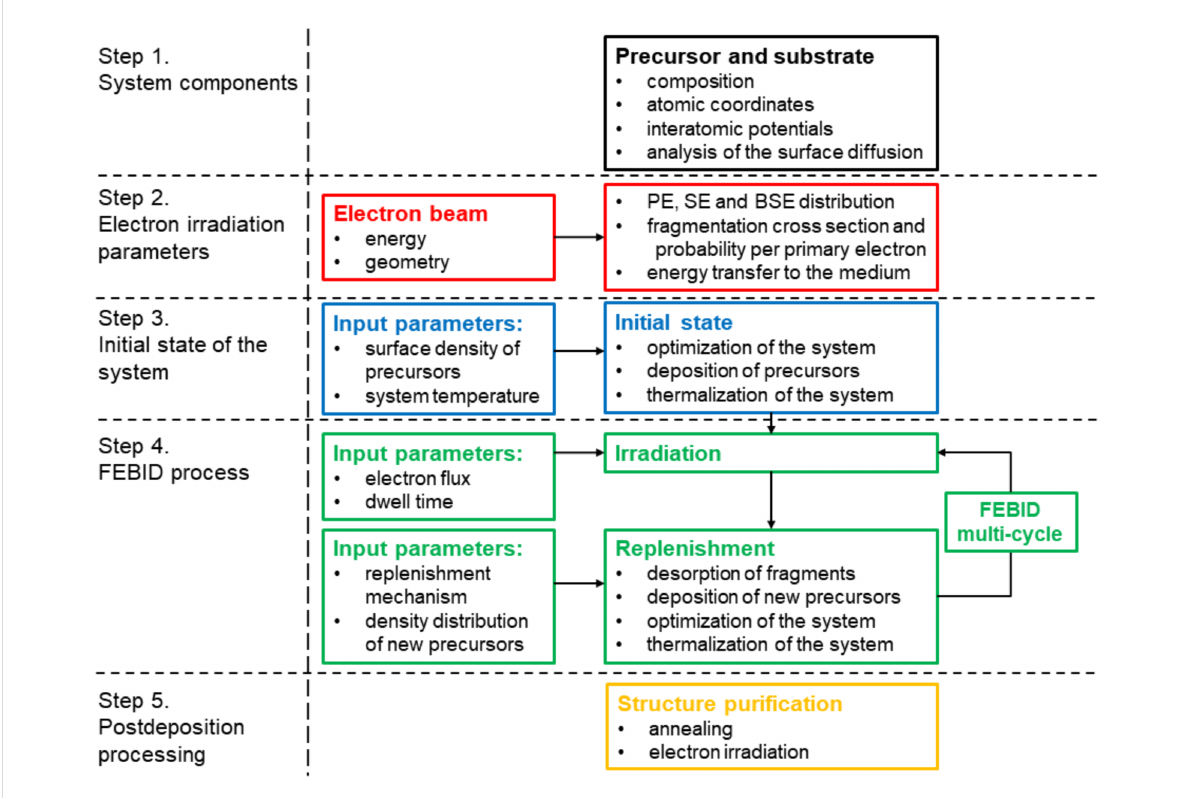
Figure 1: Atomistic IDMD-based simulation protocol of the FEBID process by means of MBN Explorer [19] and MBN Studio [20] software packages.